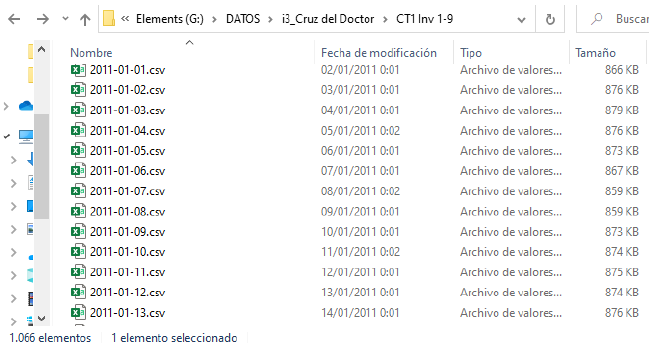
Figure 3. Directory containing CSV files with the monitoring of a set of nine inverters corresponding to a sector of a PV plant.